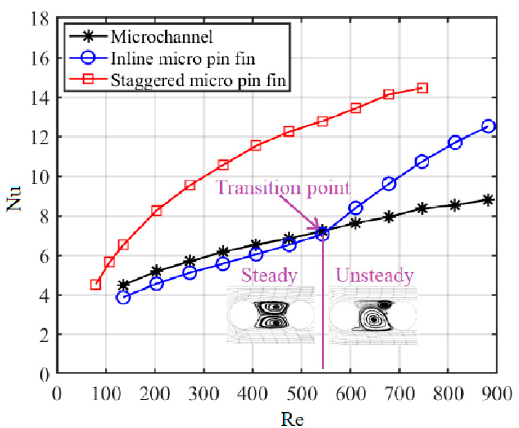
Figure 6. Variations of the average Nusselt number with the Reynolds number.